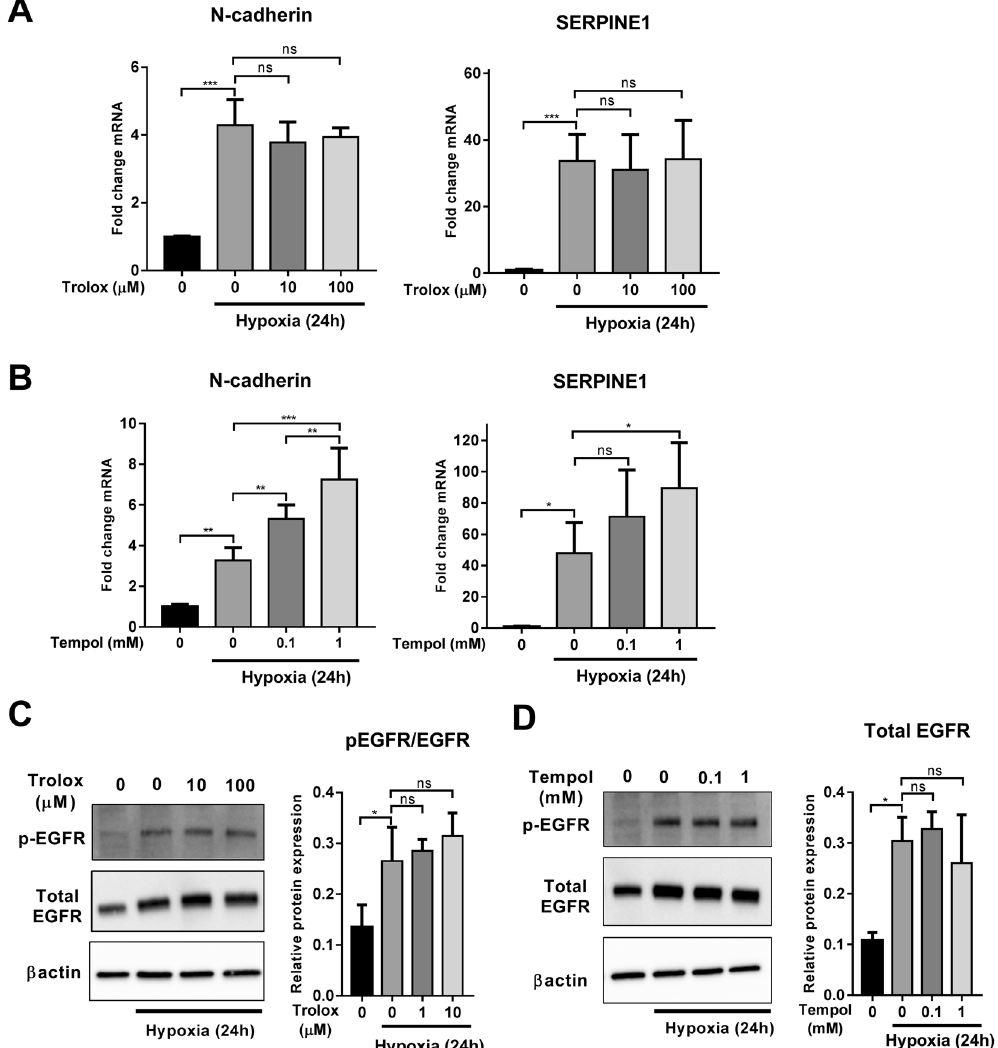
Figure 4. Effect of Trolox and Tempol on hypoxia-induced N-cadherin and SERPINE1 expression and EGFR activation. MDA-MB-468 cells were treated with Trolox (10 and 100 µ M) and Tempol (0.1 and 1 mM) and placed under hypoxic conditions for 24 h. The mRNA levels of N-cadherin and SERPINE1 following Trolox ( A ) and Tempol ( B ) treatments were assessed using real time RT-PCR. Levels of EGFR phosphorylation (normalised to β -actin and total EGFR) following Trolox ( C ) and Tempol ( D ) treatments were assessed using immunoblotting (representative cropped immunoblots are shown in the figure; full-lenght immunoblots are shown in the Supplementary Fig. S2). ns = not significant ( p > 0.05), * p < 0.05, ** p < 0.01, *** p < 0.001 (one-way ANOVA, with Tukey’s multiple comparisons test). Graphs represent the mean ± SD for three independent